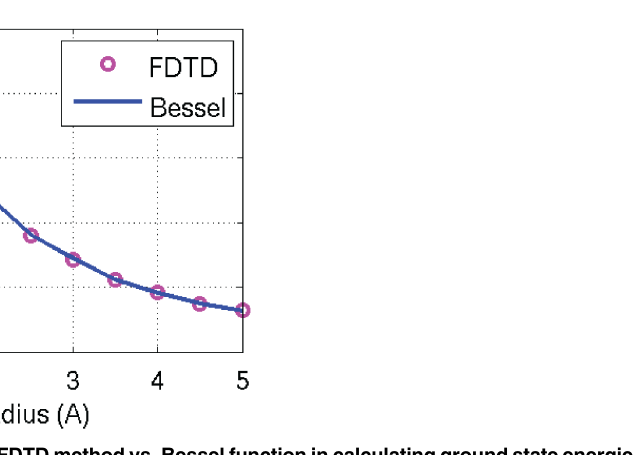
Fig 6. Comparison of the FDTD method vs. Bessel function in calculating ground state energies of the 100 Angstrom cylinder as a function of the radius of the cylinder.